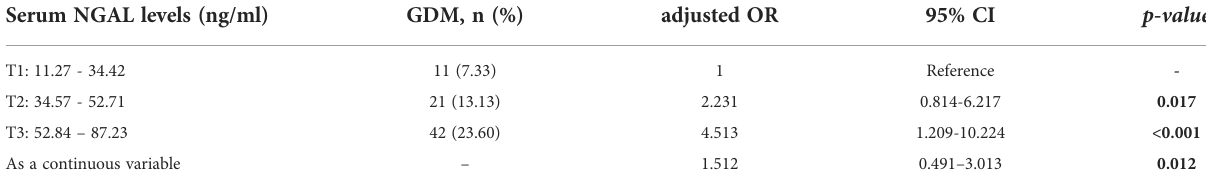
TABLE 4 Association of serum NGAL levels with the risk of GDM. Serum NGAL levels